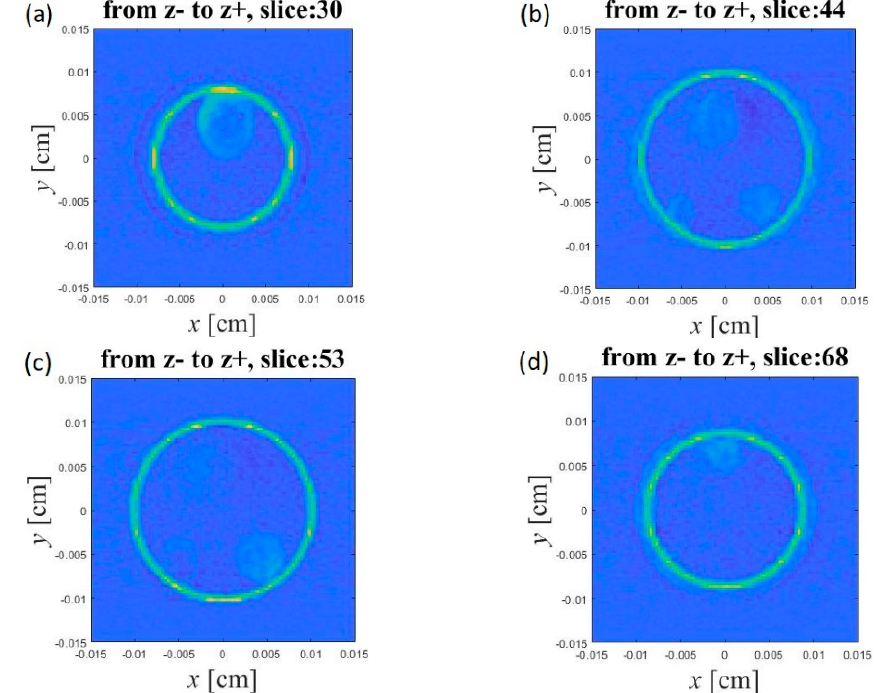
Figure 6. Three-dimensional reconstruction slice images along the z -axis of the complicated spherical sample with four small balls inside. The slice numbers and the directions are shown in each picture.